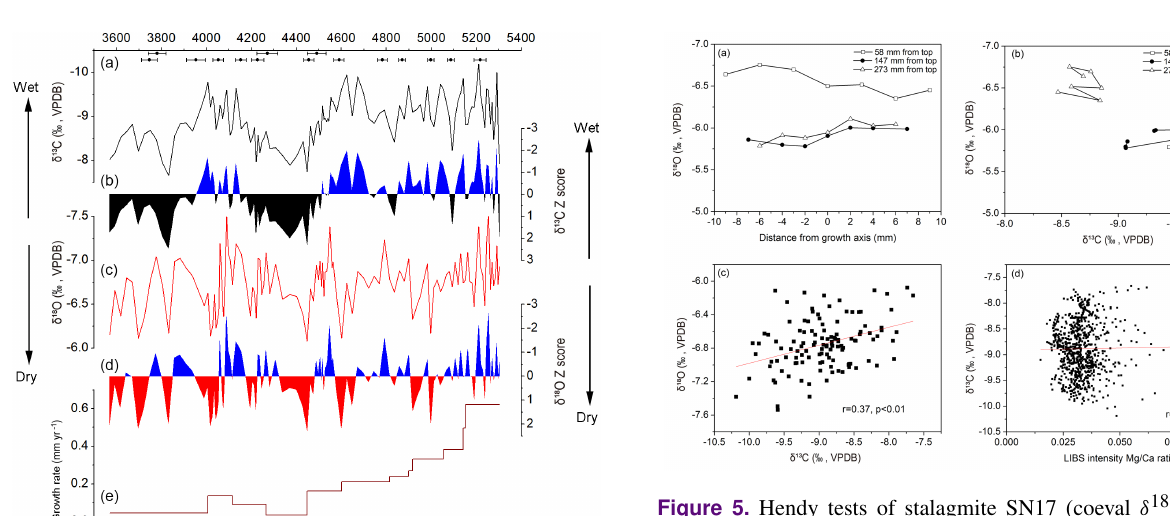
Figure 5. Hendy tests of stalagmite SN17 (coeval δ 18 O data in panel a and δ 18 O versus δ 13 C in panel b ); correlation between δ 13 C and δ 18 O values (c) and between δ 13 C values and Mg / Ca ratios (d) measured along the stalagmite growth